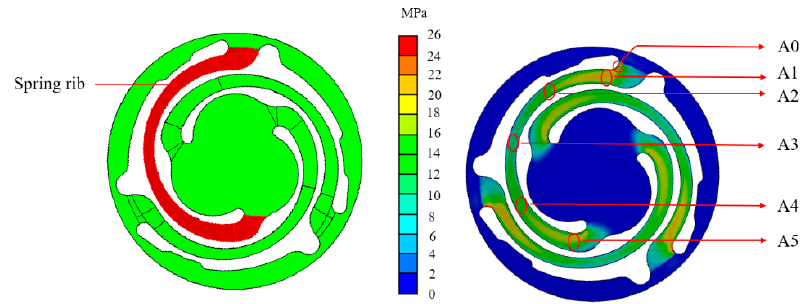
Figure 16. von Mises stress distribution on prototype spring shape.